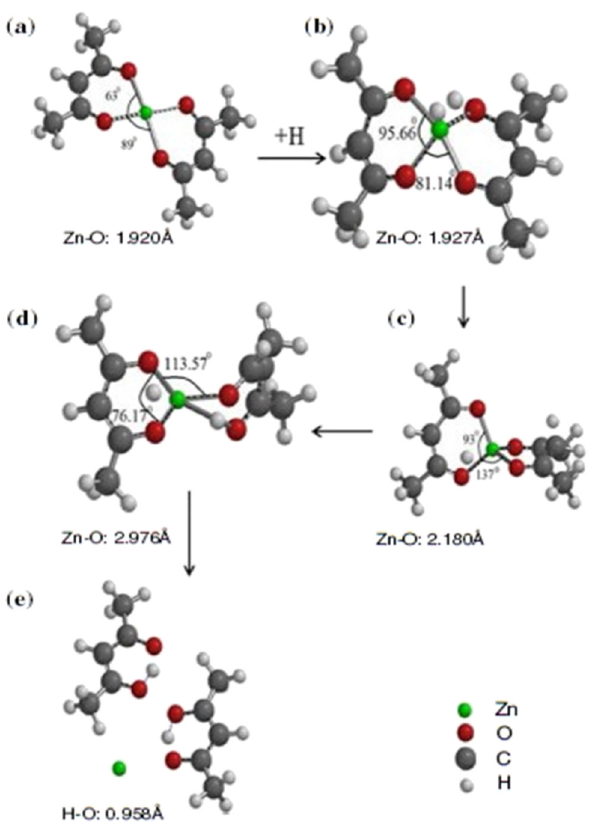
Figure 9: Steps and products in the dissociation reaction. ( a ) and ( b ) stretching and rotation of Zn – O bonds in the Zn ( acac ) 2 complex when H atoms are introduced, ( c ) stretching and torsion increase along the Zn – O bond, ( d ) the Zn – O bond reaches its maximum length as the H atoms move closer to the complex centre and ( e ) fi nal step upon the completion of Zn 2 + extraction and formation of the O and H bond [ 77 ]